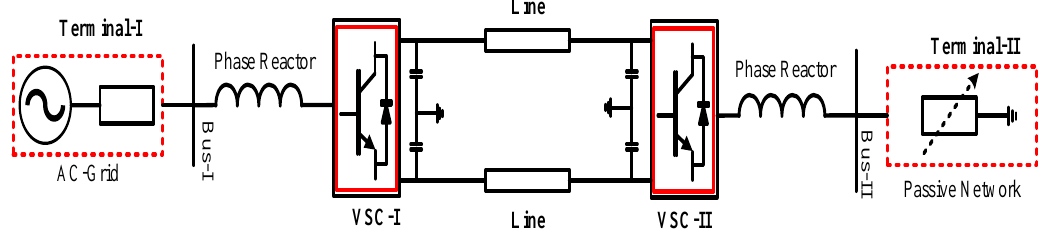
Figure 4. VSC-HVDC system with the passive network.